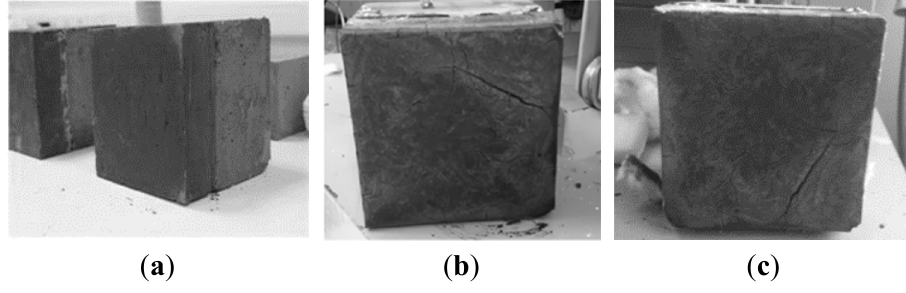
Figure 3. ( a ) Specimen before the fire tests. ( b ) Specimen after the first fire test. ( c ) Specimen after the second fire test.